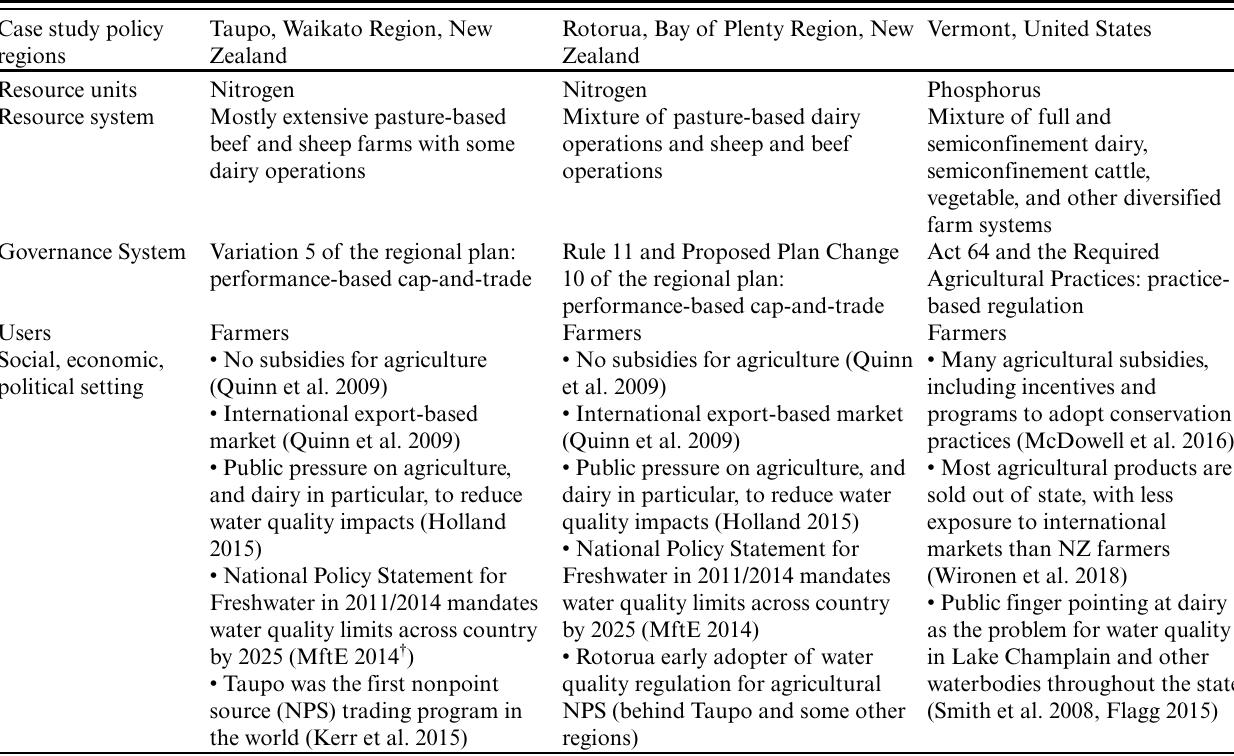
Table 1 . Social-ecological system description of the three case study